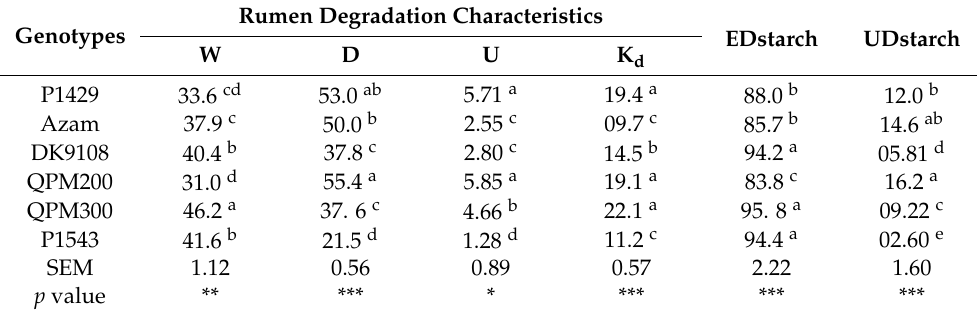
Table 4. Effect of spring maize genotypes on ruminal starch degradation kinetics and effective rumen degradability of maize silages.